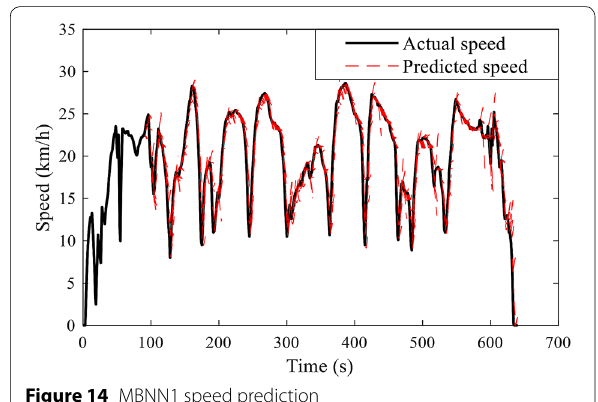
Figure 14 MBNN1 speed prediction